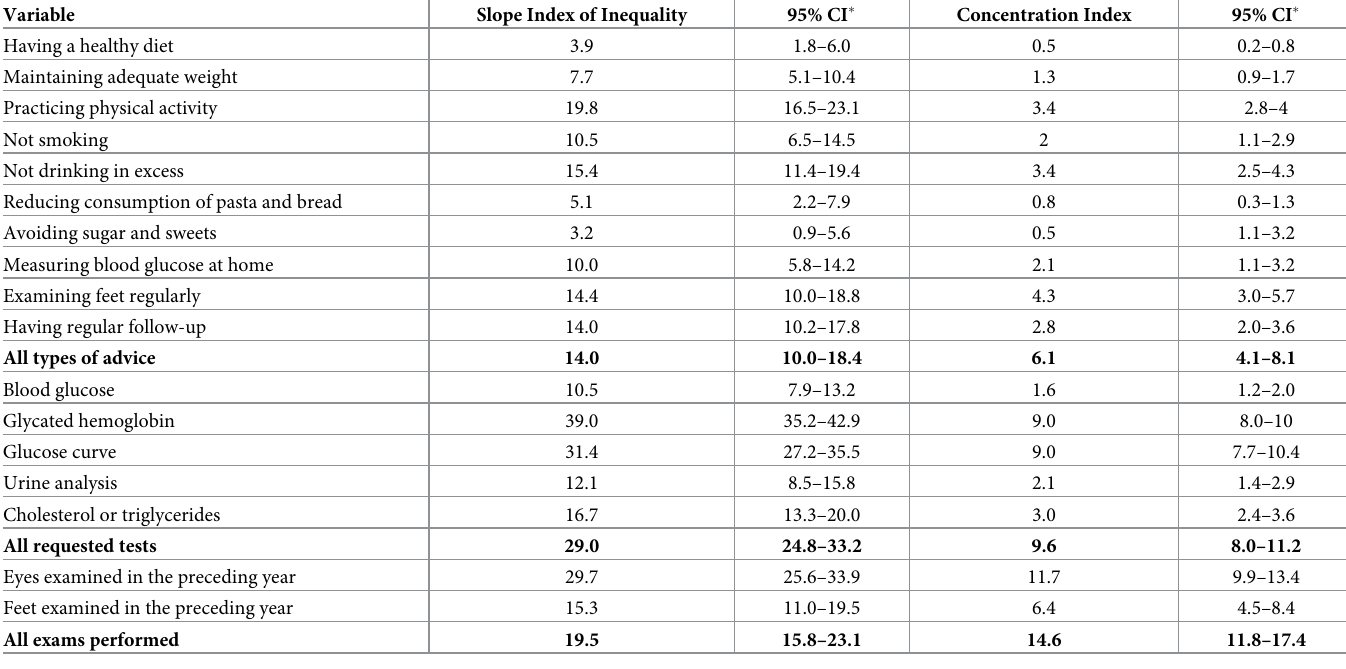
Table 3. Slope index of inequality and concentration index, with 95% confidence intervals, of the care services offered to the people with diabetes mellitus, accord- ing to educational level, Brazil, 2019 (N =